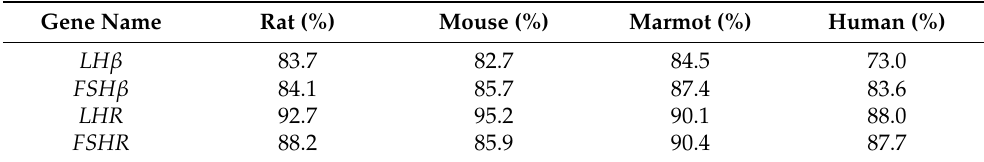
Table 2. Comparison of nucleotide sequence homology between the plateau zokor ( Eospalax baileyi ) and rats ( Rattus rattus ), mice ( Mus musculus ), marmots ( Marmota marmota ), and humans ( Homo sapiens